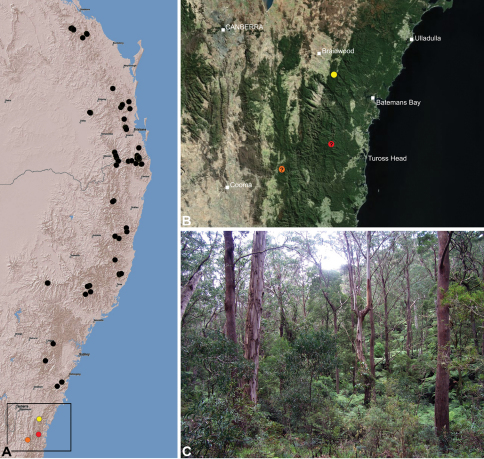
Austrarchaea mcguiganae sp. n., distribution and habitat: A, topographic map showing the known distribution of Archaeidae in south-eastern Queensland and eastern New South Wales, with collection localities for A. mcguiganae highlighted in yellow (red highlighted localities denote specimens of tentative identification; orange highlighted localities denote genotyped juvenile specimens of tentative identification); B, satellite image showing detail of inset (A); C, wet eucalypt forest at the type locality – Link Road, Monga National Park, New South Wales (April 2010). Image (C) by M. Rix.